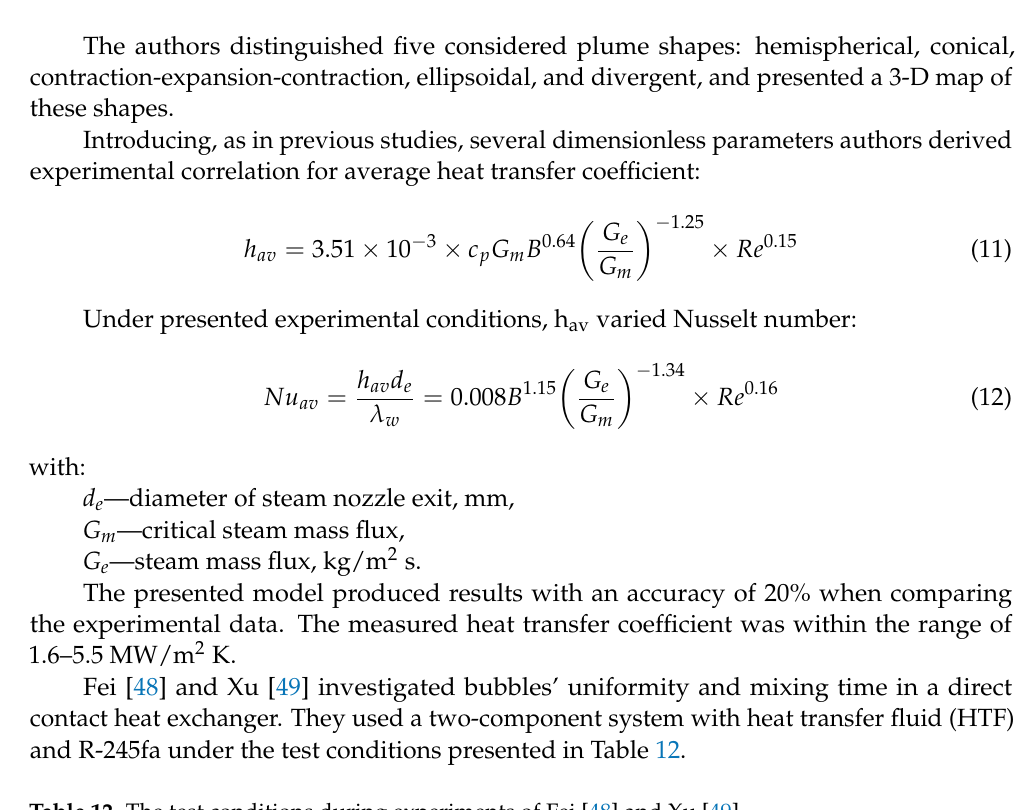
Table 12. The test conditions during experiments of Fei [48] and Xu [49]. Quantity Range Unit Column